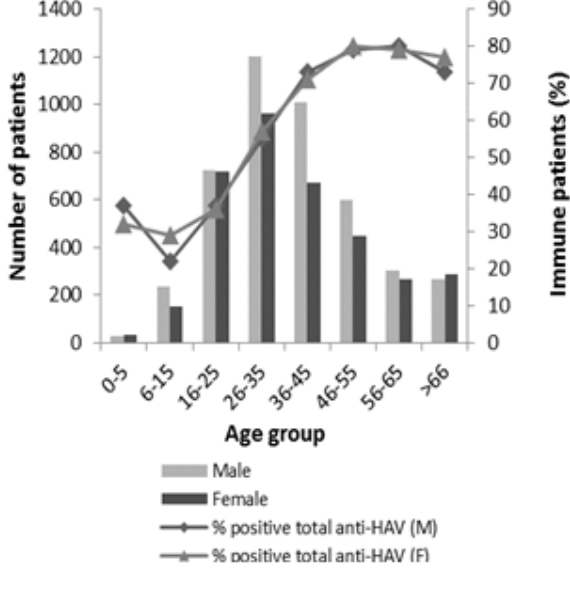
Figure 4. Percentage of immune patients by genre and age group. M–Male; F–Female.